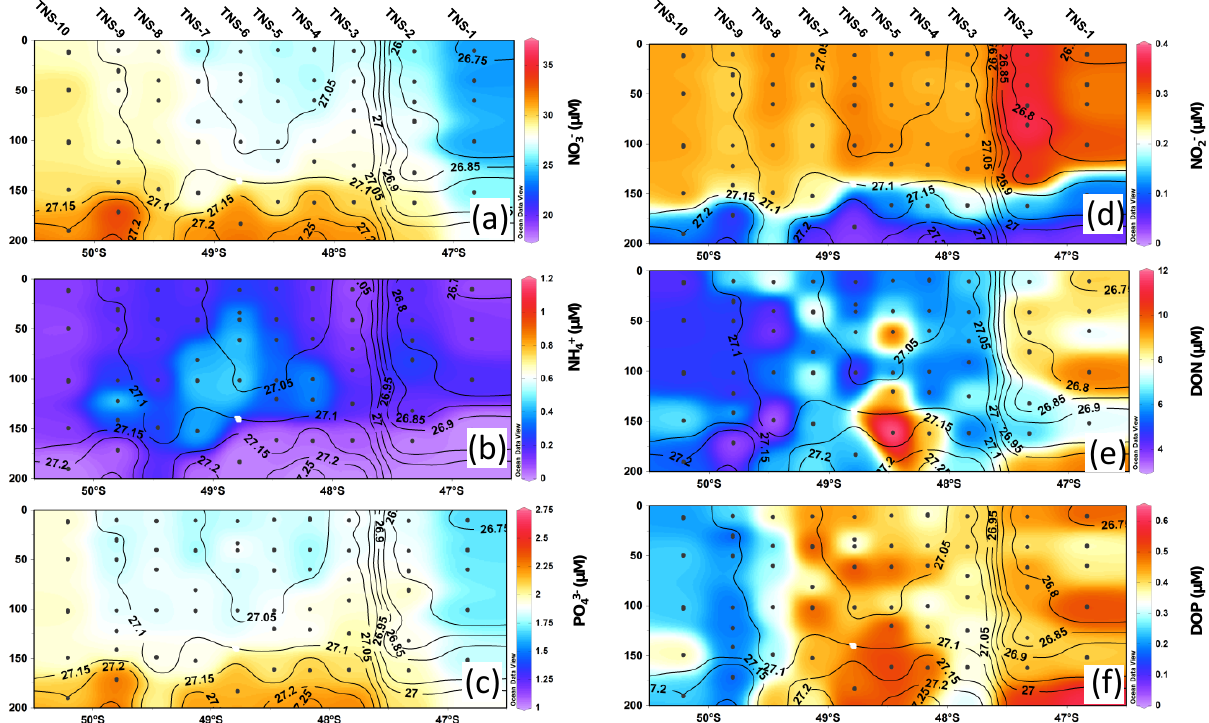
Figure 3. Vertical sections of dissolved nitrogen and phosphorus species along the North-South transect (TNS). (a) nitrate, (b) ammonium, (c) phosphate, (d) nitrite, (e) dissolved organic nitrogen, (f) dissolved organic phosphorus. The isolines for density anomaly ( σ ) are plotted on each